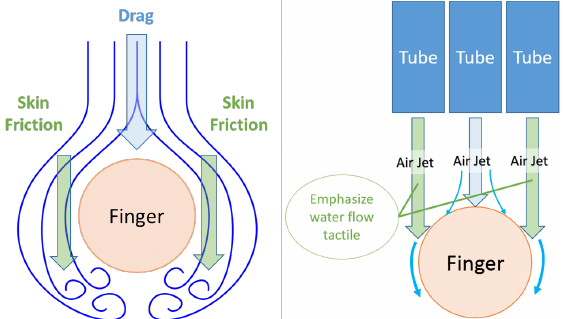
Figure 2. The sensation of fluid flow is a combination of the drag force and skin friction. We added additional air tubes on the left and right to emphasize skin friction on both sides of the